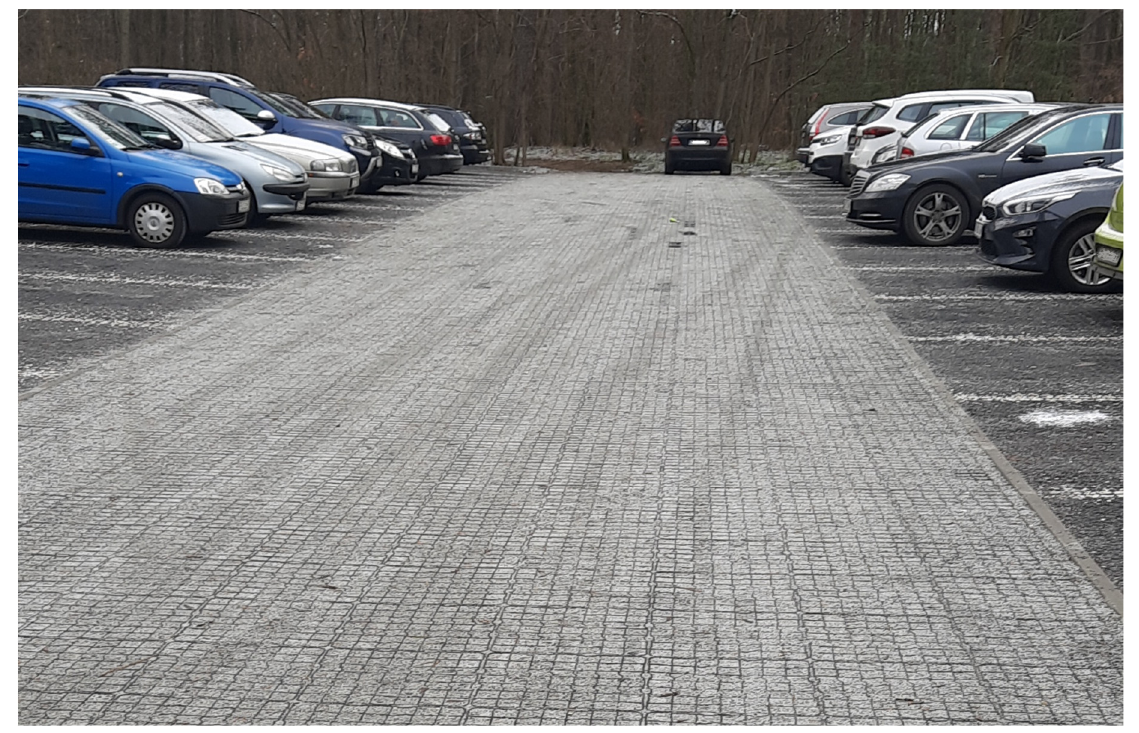
Figure 2. Example of rainwater permeable parking places and manoeuvring area—Zielona Góra, Cisowa Street.